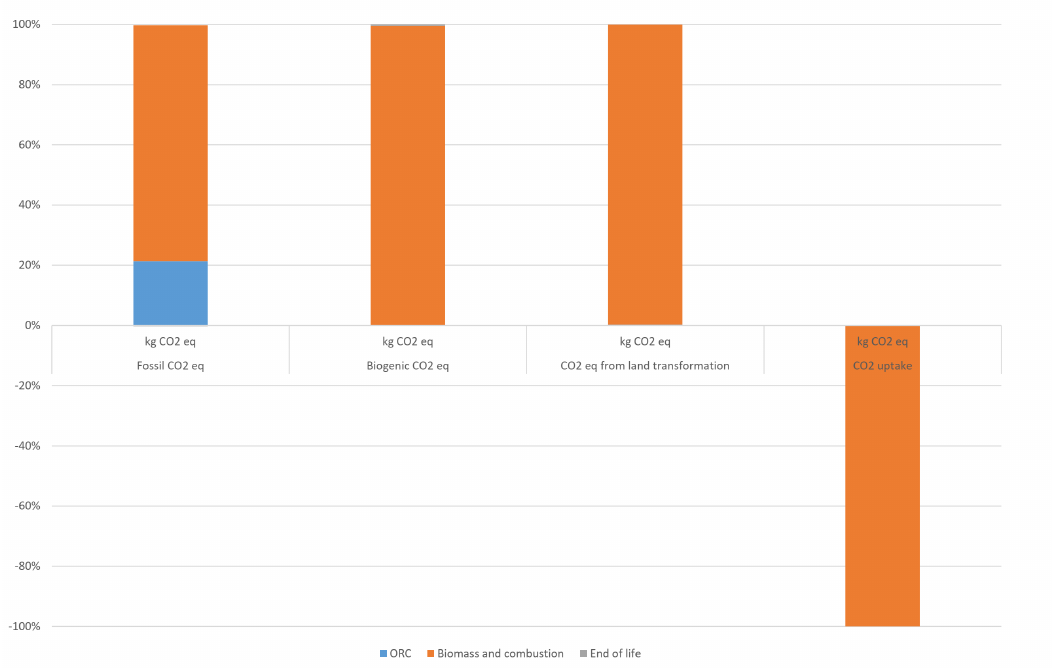
Figure 8. Carbon